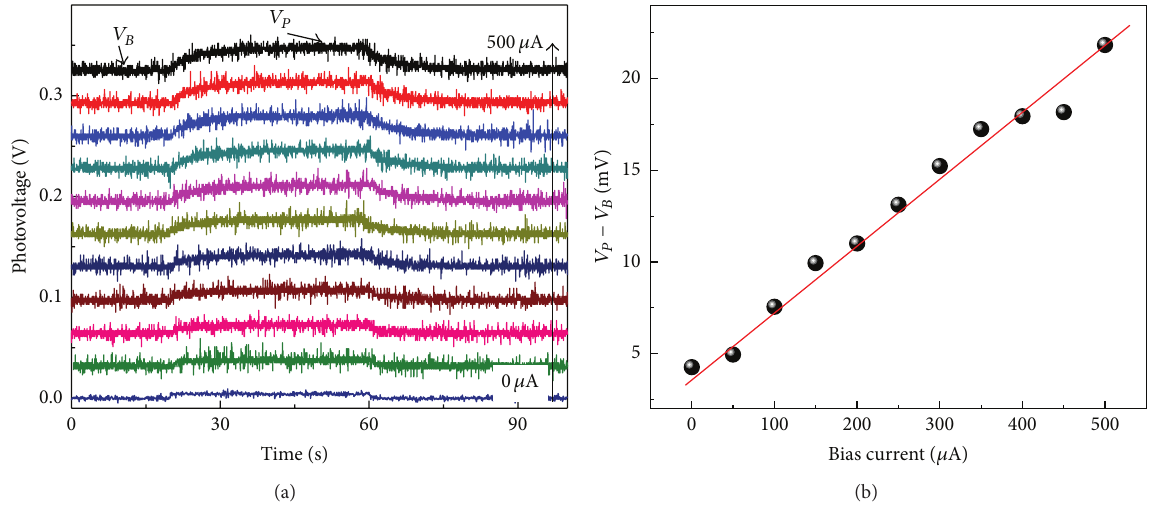
Figure 4: (a) The typical waveforms with bias currents applied from 0 to 500 𝜇 A at 𝑥 = 1.5 mm. (b) The photoinduced LPV defined by ( 𝑉 𝑃 − 𝑉 𝑅 ) dependence on the bias